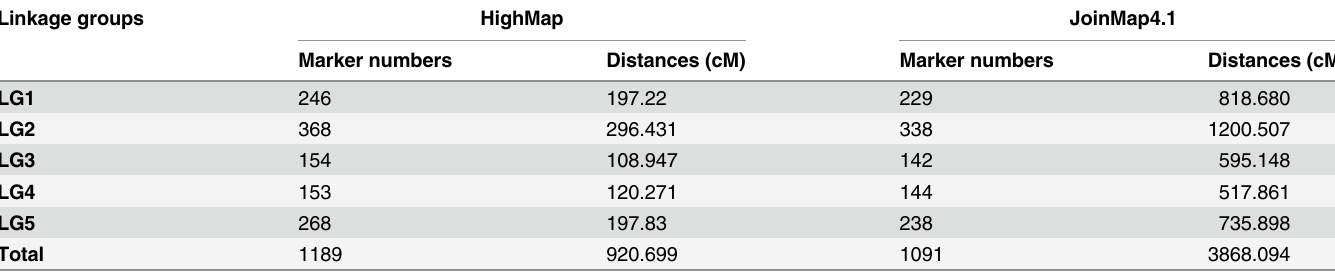
Table 7. Genetic linkage map of tree peony constructed by HighMap and JoinMap4.1. Linkage